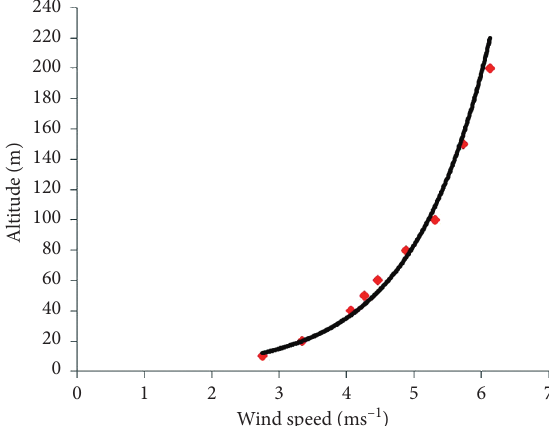
Figure 6: Vertical profiles of adjusted wind speed (m s − 1 ) from WRF simulation at Bac Lieu station. The red dots mark simulated wind speed at the levels. The black curve is the best fitting logarithm function of the wind speed